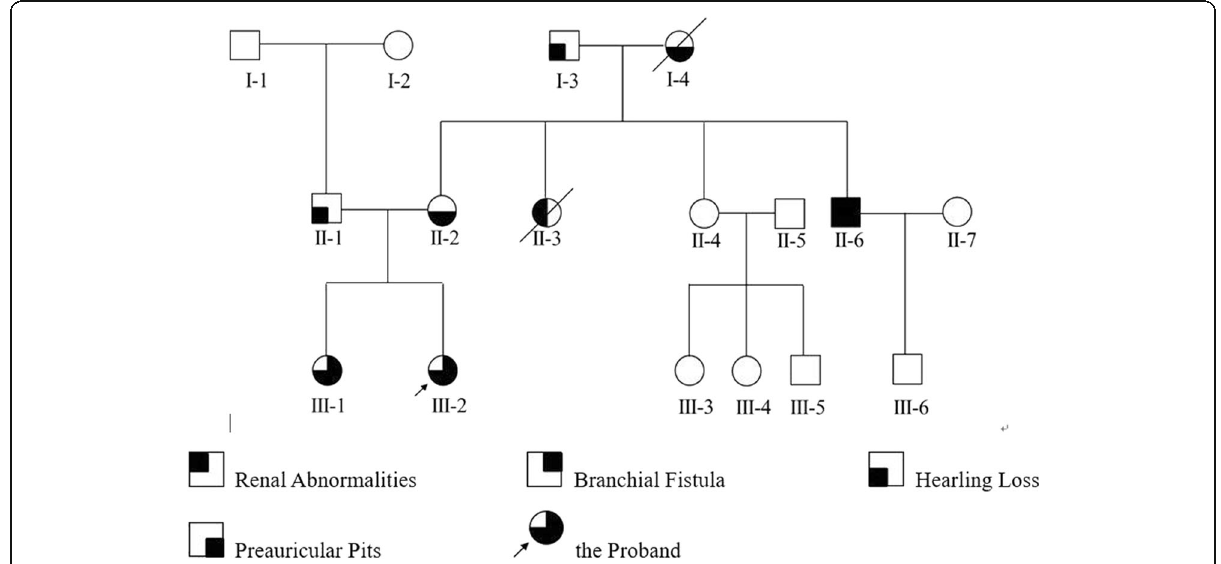
Fig. 1 Pedigree of a family with branchio-oto-renal (BOR)